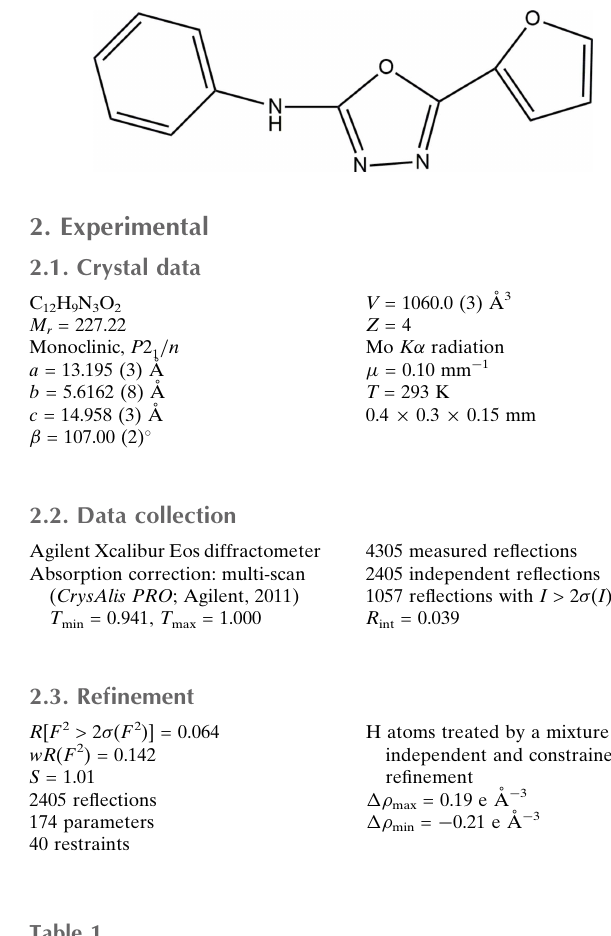
Hydrogen-bond geometry (A˚ , (cid:2)